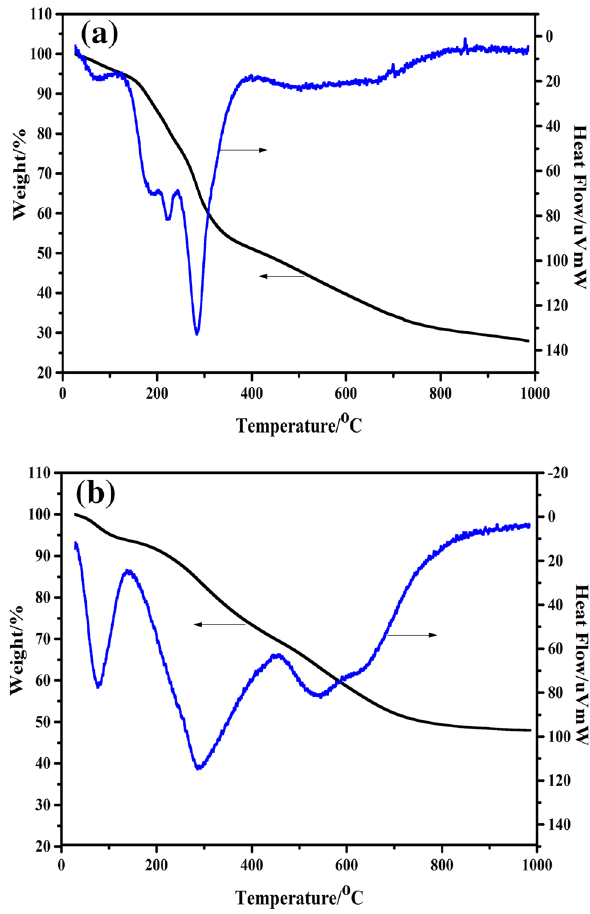
Fig. 5 TG and DTG curves of depolymerization products of coal at different pH a pH = 0.012; b pH =